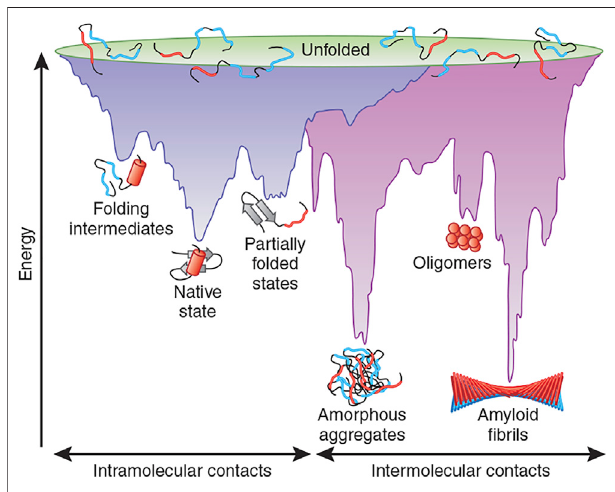
FIGURE 7 | Energy landscape scheme of protein folding and aggregation. The scheme shows multiple conformations “ funneling ” to the native state via intramolecular contacts (purple surface) as well as conformations moving toward amorphous aggregates or amyloid fi brils via intermolecular contacts (pink area). Reprinted from (Hartl and Hayer-Hartl, 2009)withpermission from SpringerNatureCustomerServiceCentreGmbH, Springer Nature, Copyright (2009).